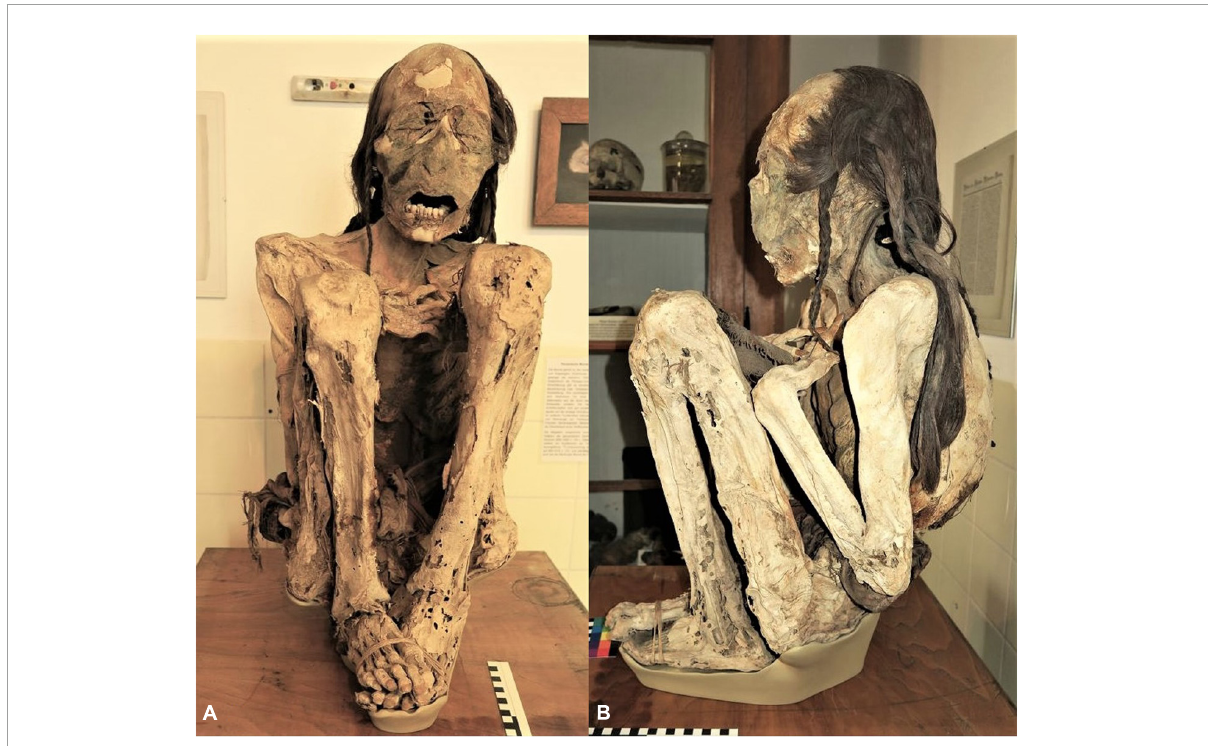
FIGURE1 The “Marburg mummy”—Macroscopic views of the whole mummy. (A) Frontal and (B) lateral